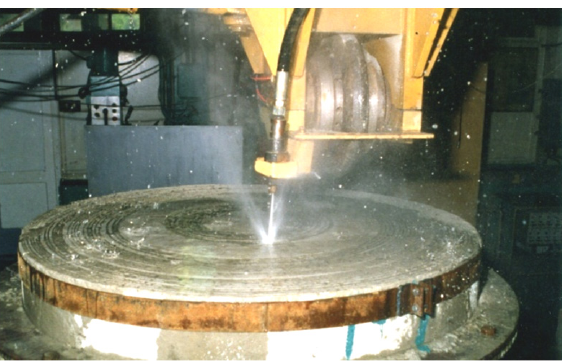
Figure 14. The view of concrete sample cutting using HPW jet: d = 0.8 mm, L = 70 mm, p = 60 MPa [1]. The tests of mining the samples with a disc tool were conducted separately for mining without and with HPW jets, for three mining radius R u of 250, 350 and 500 mm. Measure- ments were made using tools with three different edge angles 2 b and for samples with three different values of compressive strength R c . In the case of mining without water jet assistance, one cut on the concrete sample was made with a radius R u of 350 mm and two cuts with radius R u = 250 and 500 mm, due to the possibility of adjacent cuts interacting with each